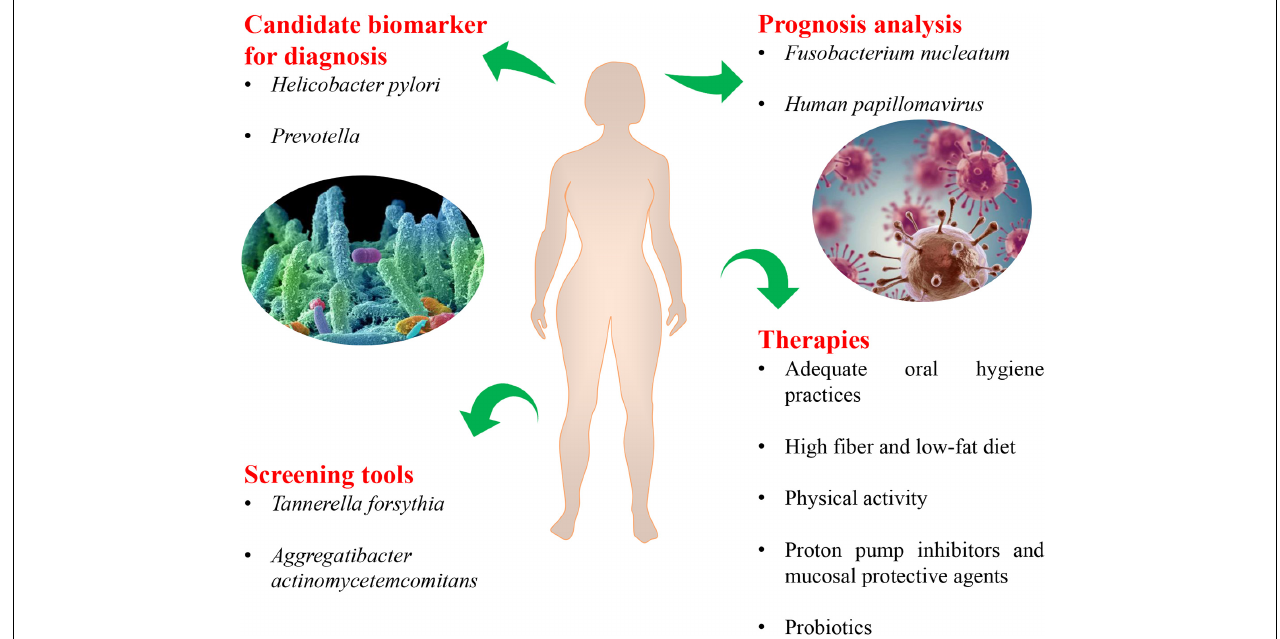
FIGURE 3 | The molecular mechanisms of microbe-mediated in EAC carcinogenesis. On the basis of the known contribution of human microbiota in esophageal carcinogenesis, the main mechanisms included inflammation, metabolism, and genotoxicity. Alteration of human microbiota in EAC showed a shift toward Gram-negative bacteria. Some specific pathogens, such as Campylobacter concisus , Helicobacter pylori , and Escherichia coli , involved in the process of inflammation and EAC cascade by regulating the expressions of toll-like receptors (TLRs) and pro-inflammatory mediators such as TNF- α , IL-18, COX-2, prostaglandins. And the components of Gram-negative bacteria activated the NLRP3 inflammasome and NF- κ B pathway. Besides, detrimental metabolites, such as hydrogen sulfide, products of protein fermentation and bile acid metabolism, could play an important role in the initiation and progression of EAC. Some Gram-negative bacteria produced the cytolethal distending toxin (CDT), which could induce DNA damage and trigger EAC carcinogenesis. LPS, lipopolysaccharides; NF- κ B, nuclear factor kappa B; TLRs, toll-like receptors; CDT, cytolethal distending toxin; TNF- α , tumor necrosis factor- α ; IL, interleukin; COX, cyclooxygenase; PG, prostaglandin; p53, tumor protein 53; NLRP3, nucleotide-binding domain and leucine-rich repeat-containing protein 3.